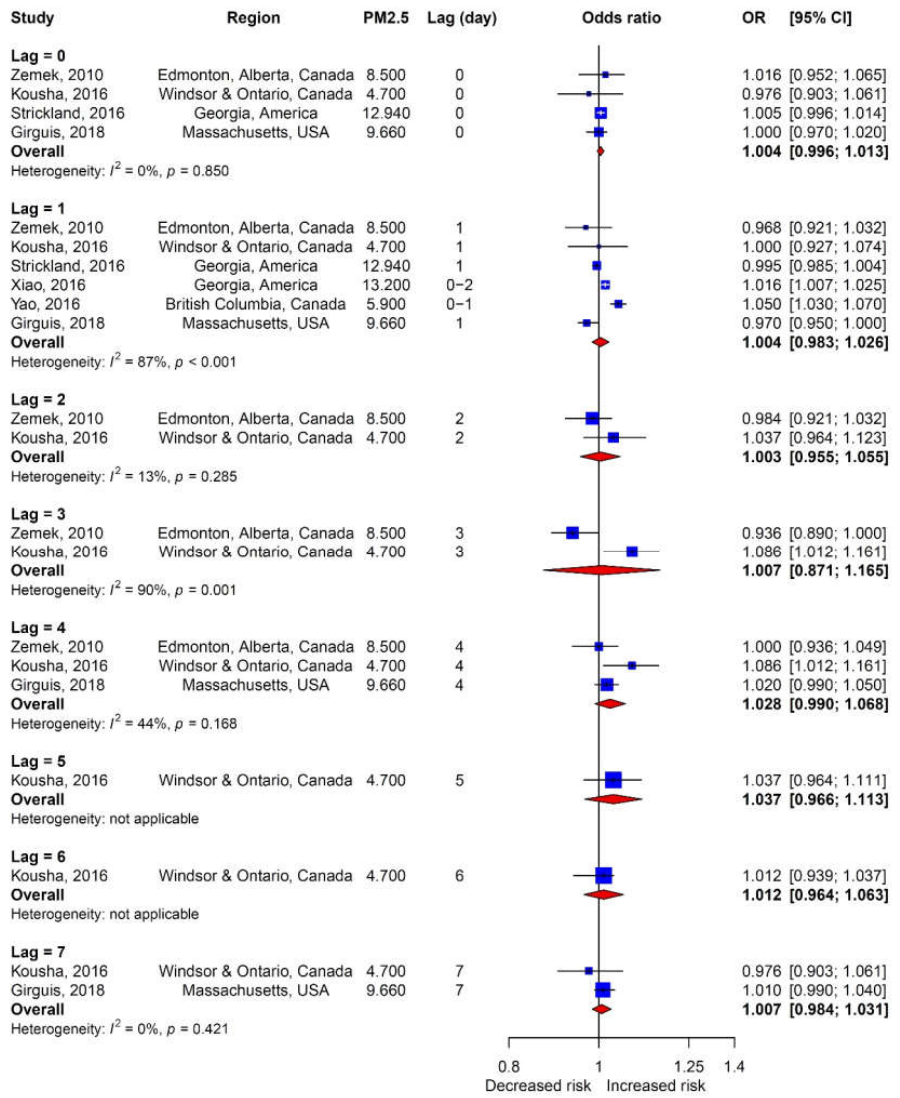
Figure 5. Funnel plot of publication bias in the (A)—PM 2.5 and (B)—PM 10 groups.